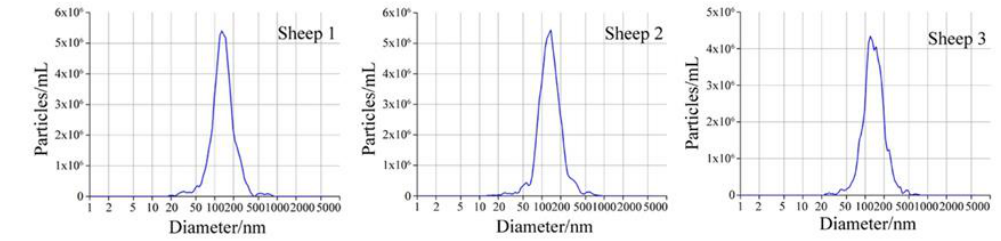
Figure 2. Nanoparticle tracking analysis of sheep milk extracellular vesicles (EVs).